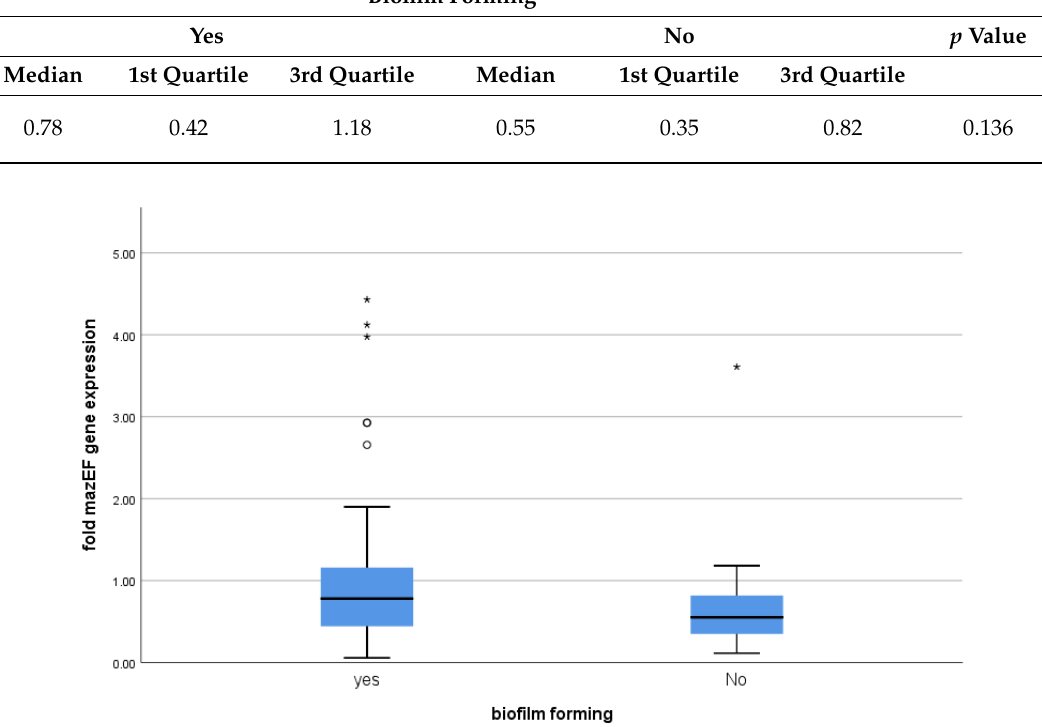
Figure 4. The mazEF expression in relation to biofilm-formation. On the boxplot, circles ◦ represent outliers and stars * represent more extreme values.